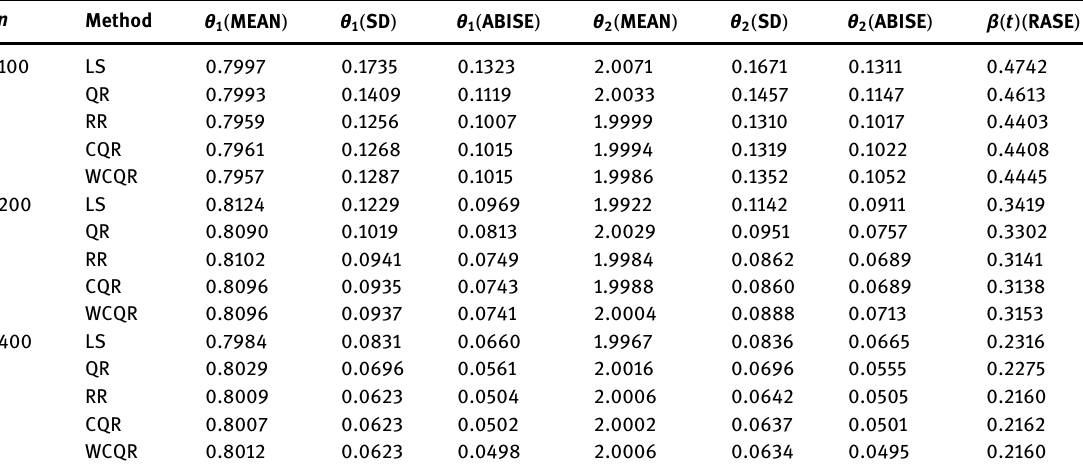
Table 2: Simulation results for θ with t ( 3 ) random